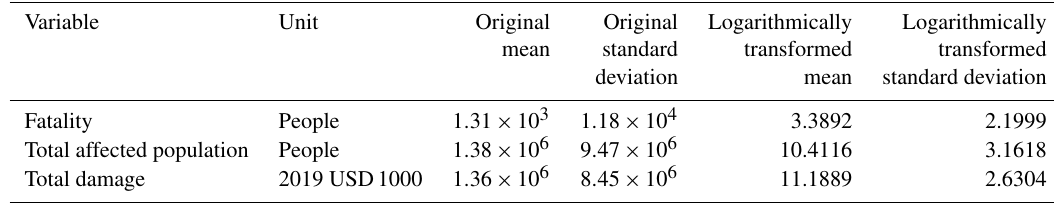
Table 1. Means and standard deviations of original and logarithmically transformed impact variables a . Variable Unit